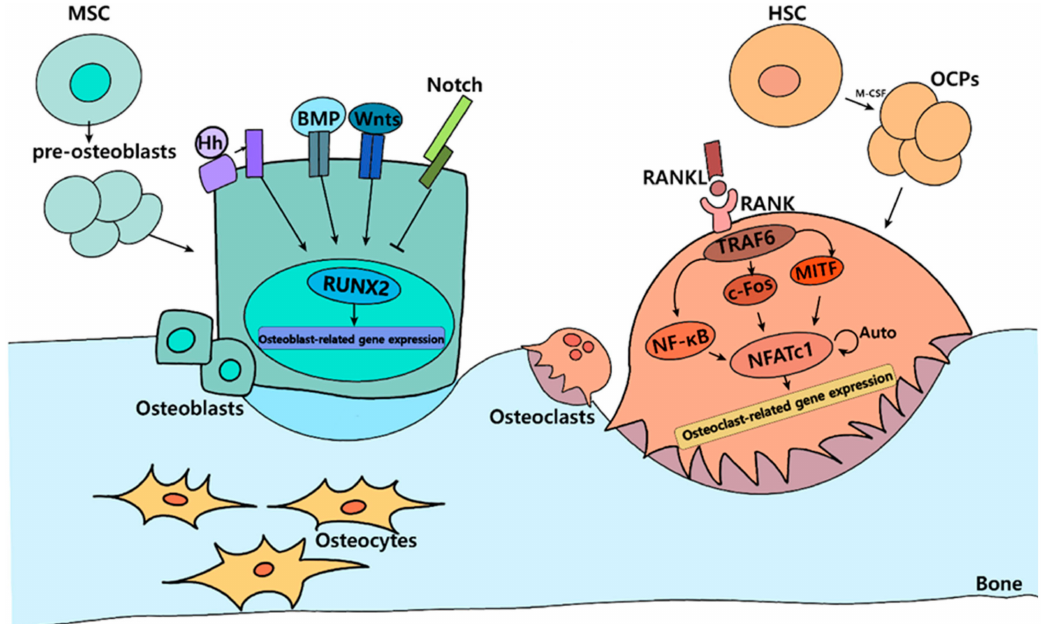
Figure 1. Signaling pathways of bone remodeling. At a specific area of damaged or old bone, osteocytes recruit osteoclast precursor cells (OCPs), which are di ff erentiated from hematopoietic stem cells (HSCs). The receptor activator of nuclear factor kappa-B ligand (RANKL) binds to RANK on OCPs membrane and activates multiple signaling pathways, inducing nuclear factor of activated T-cells, cytoplasmic 1 (NFATc1) via nuclear factor-kappaB (NF- κ B), c-Fos, or microphthalmia-associated transcription factor (MITF). NFATc1, as a master transcription factor, stimulates osteoclastogenic genes and thus osteoclast di ff erentiation. Mature osteoclasts resorb a damaged or old bone matrix and subsequently osteoblasts are recruited into resorbed bone surfaces and from new bone. Mesenchymal stem cells (MSCs) di ff erentiate into osteoblasts through various signaling pathways, such as bone morphogenic protein (BMP), Wnt, Hedgehog (Hh), and Notch. Runt-related transcription factor 2 (RUNX2) is a primary transcription factor, implicated in those pathways as a focal point for signaling